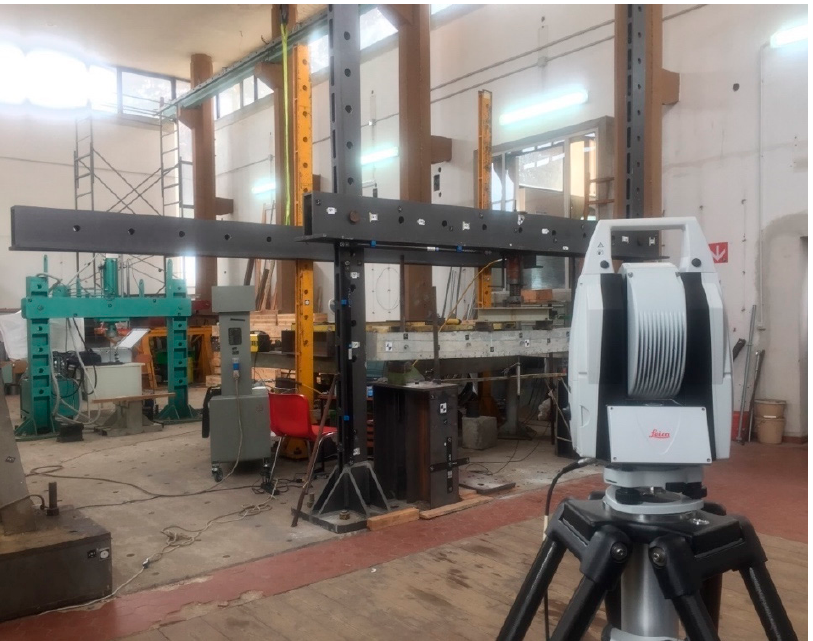
Figure 2. Experimental setup: Beam and back-up frame, Laser Tracker (LT) pointing at targets.